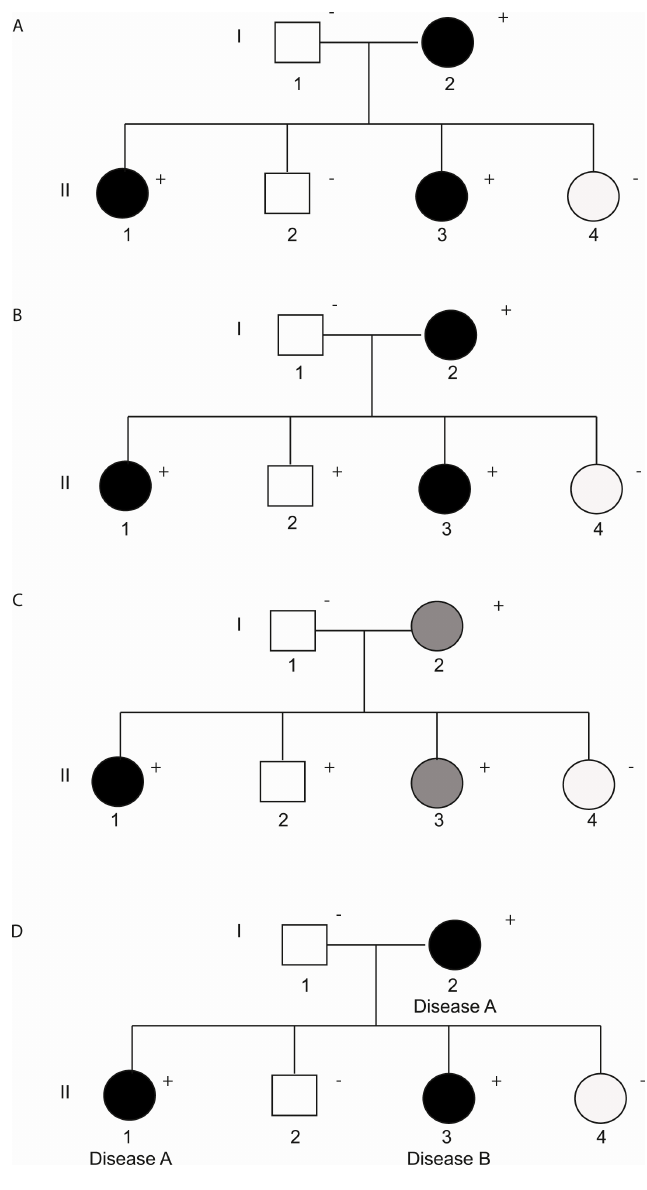
Figure 1. ( A ) Pedigree displaying complete penetrance; ( B ) Pedigree with incomplete penetrance because individual II:2 carries the mutation but is not affected; ( C ) Pedigree demonstrating incomplete penetrance and variable expressivity due to individual II:3 who carries the mutation but presents a less severe disease; ( D ) Pedigree showing phenotypic overlap because individual II:3 shows a different cardiac channelopathy. Clinically affected patients are shows in black, clinically unaffected patients are show in white and grey indicates a less severe phenotype. A plus sign indicates a carrier of the genetic variant. A minus sign indicates a non-carrier.